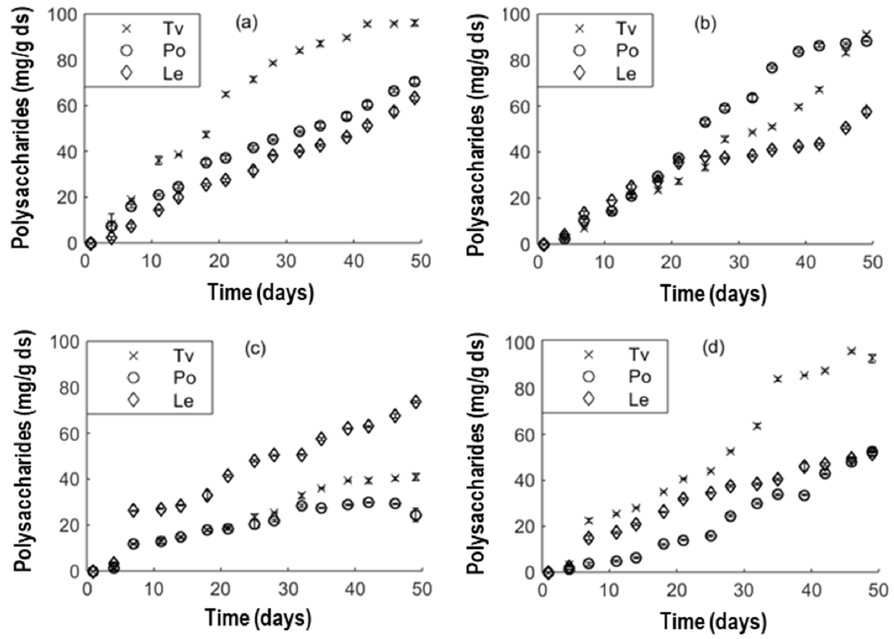
Figure 2. Polysaccharide production of T. versicolor (Tv), P. ostreatus (Po), and L. edodes (Le) grown on different solid media based on oak sawdust, coconut fiber, coffee husks, corn bran, and soybean oil during 49 cultivation days under solid-state fermentation (SSF) conditions. ( a ) Polysaccharide concentration in F2 medium. ( b ) Polysaccharide concentration in F4 medium. ( c ) Polysaccharide concentration in F10 medium. ( d ) Polysaccharide concentration in F11 medium. The formulation for each medium is deciphered in Table 1; ds: dry